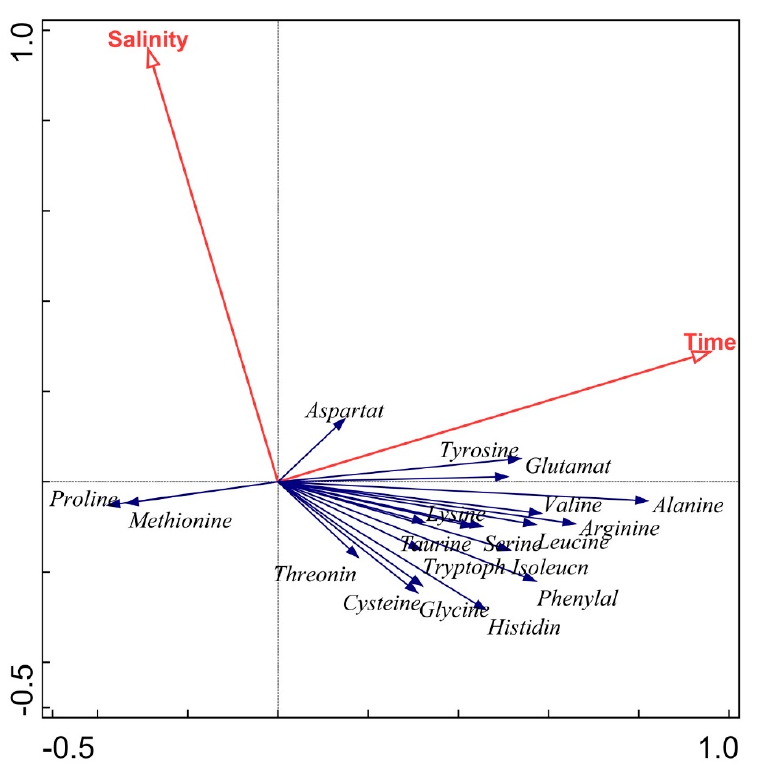
Figure 5. Redundancy analysis (RDA) between stress time, salinity level, and amino acids. The red arrows present different stress factors, and the black arrows represent each kind of amino acids.